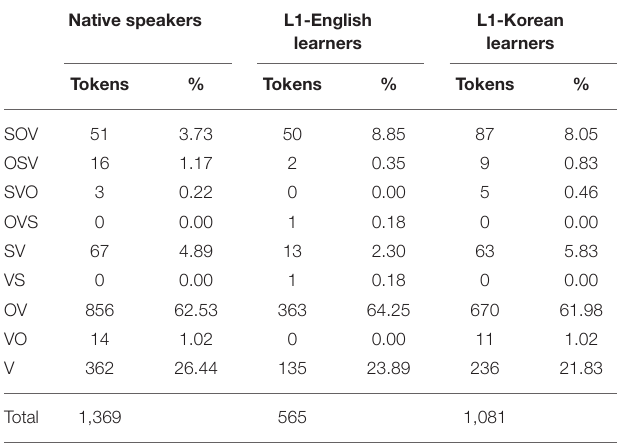
TABLE 5 | Availability, reliability, and validity of the word-order cue (SOV) in sentences with an overt subject and